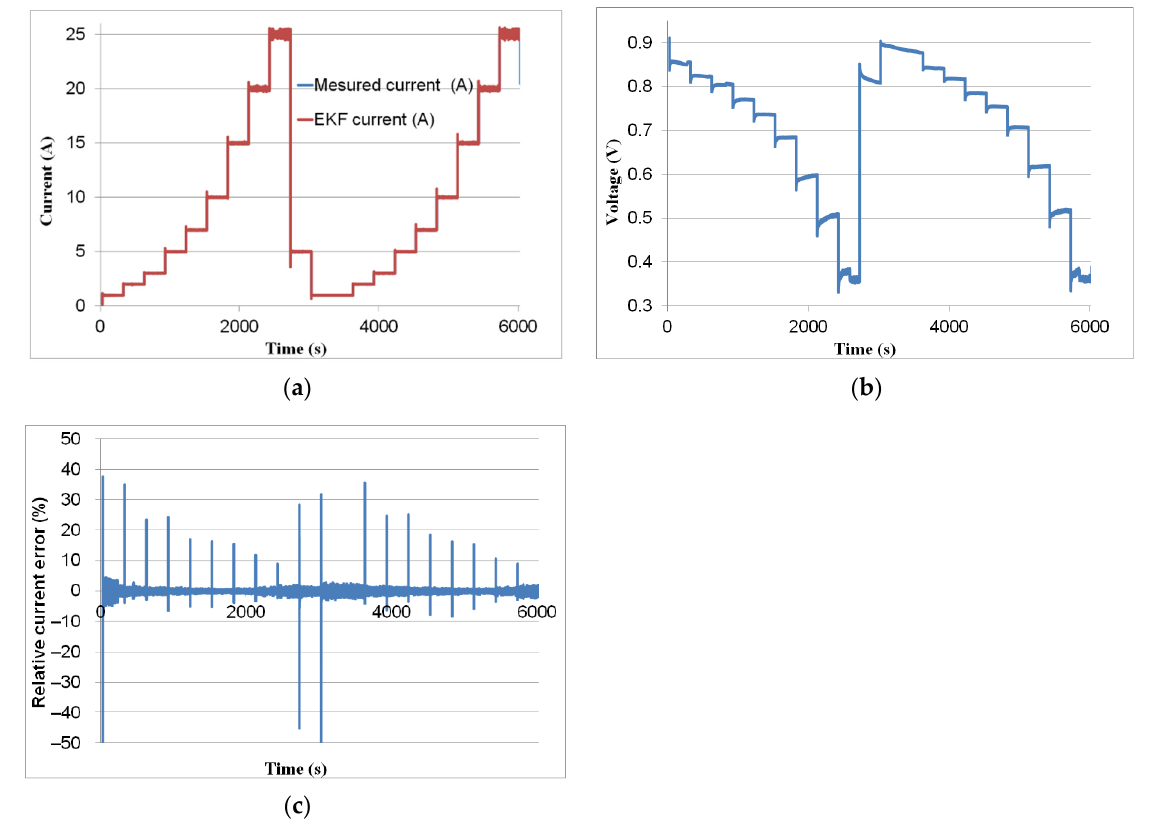
Figure 12. ( a ) Measured current and current estimated by EKF. ( b ) Experimental voltage of a new PEMFC cell for step-up/down profile. ( c ) Relative error of the estimated current.